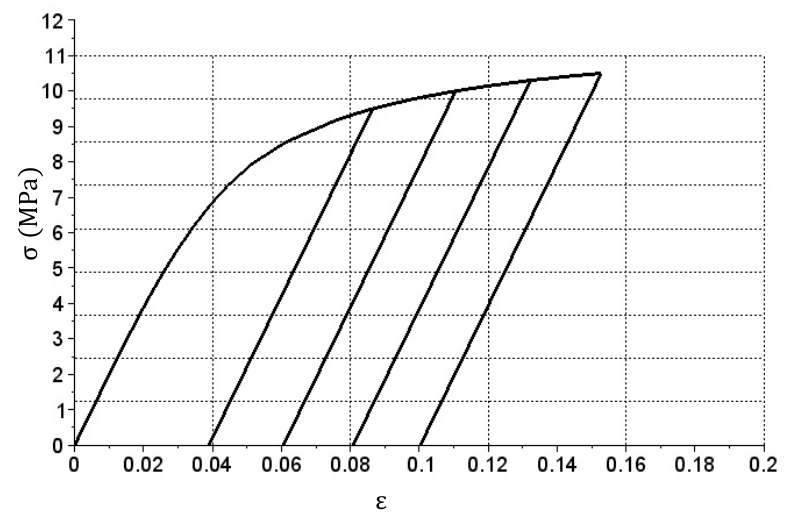
Figure 10. σ ( ε ) relation graph for the simulation of cyclic tension and relief of the bar. Figure 10. σ(ε) relation graph for the simulation of cyclic tension and relief of the bar. In this case, only the E p matrix was used during the first load cycle. During the relief and another load stage to the previously achieved stress level, the values were taken from the E n matrix. When applying load above the previously achieved stress level, the E p matrix was